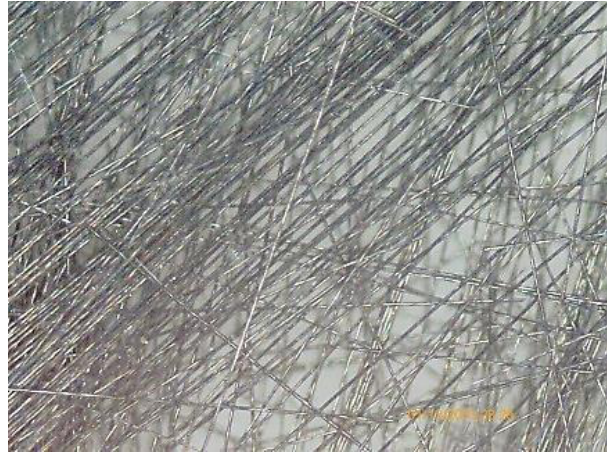
Figure 4. Micrograph (×1000) of fully calcined